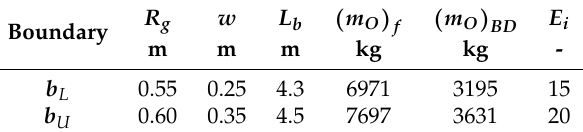
Table 2. Design parameters ranges: GPFS.